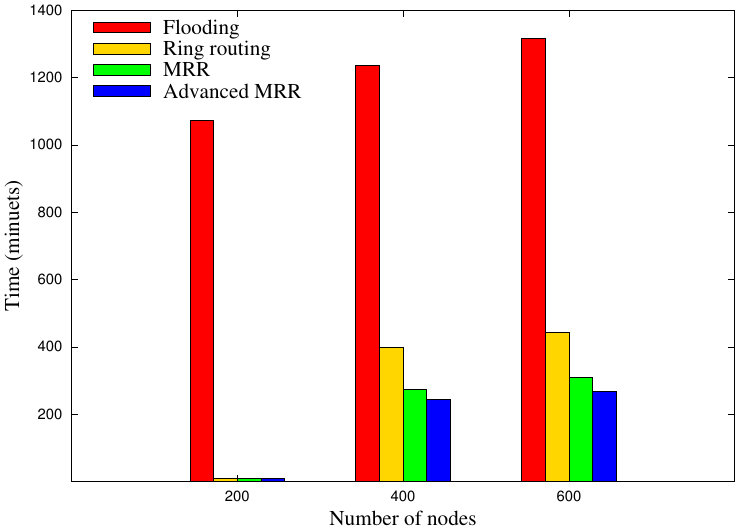
Figure 14. Expected blackout time for each node for 30 days, which is the average value of 50 runs in each network